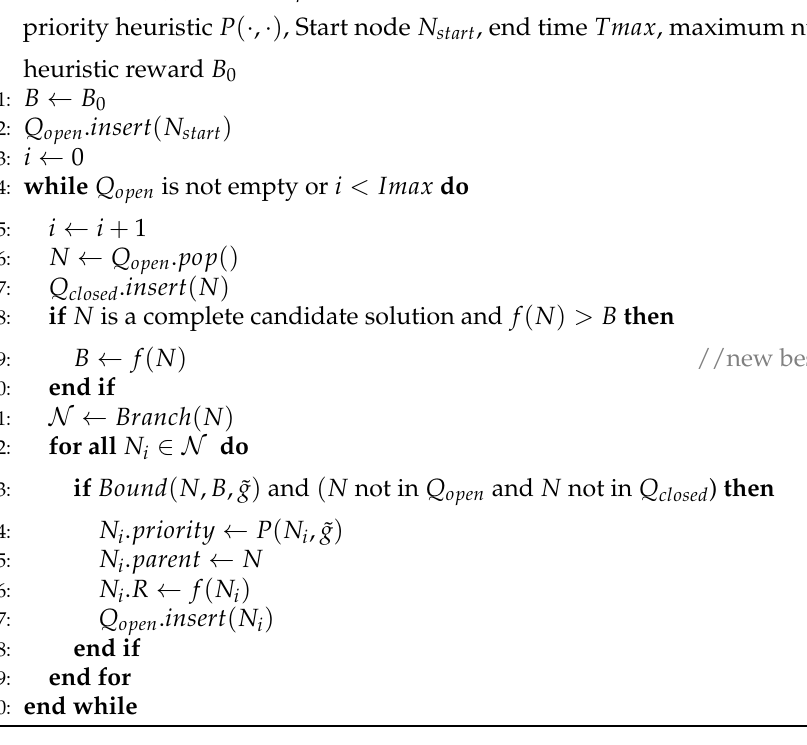
heuristic reward B 0